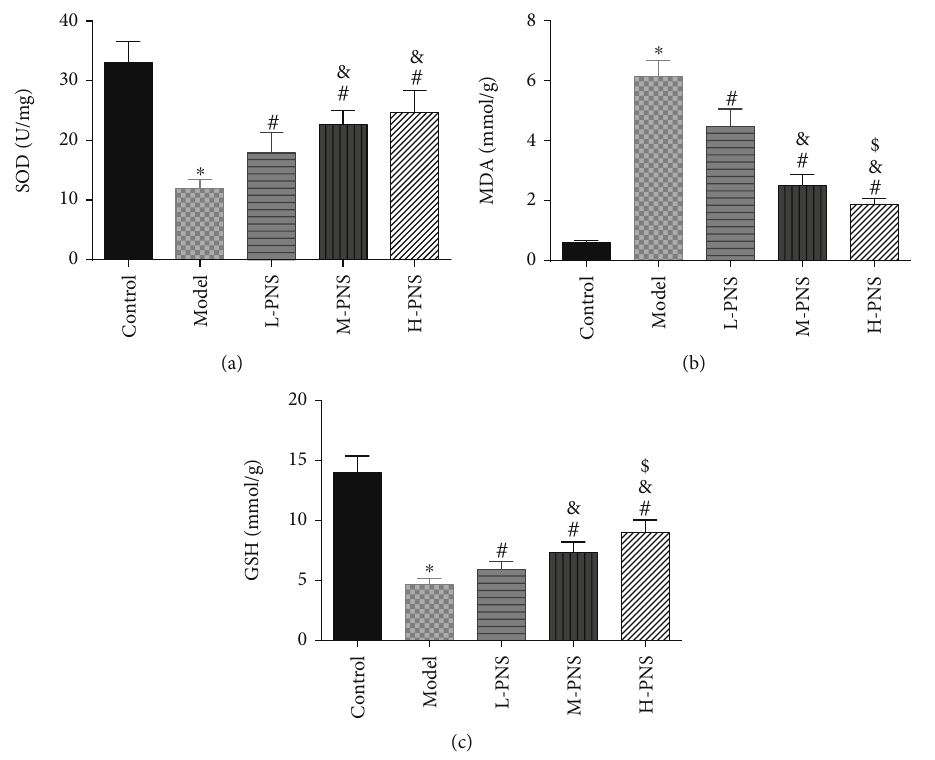
Figure 4: Changes of oxidative stress indicators ((a) SOD activity. (b) MDA content. (c) GSH content; ∗ P < 0 : 05 vs. control; # P < 0 : 05 vs. model; & P < 0 : 05 vs. L-PNS; $ P < 0 : 05 vs.